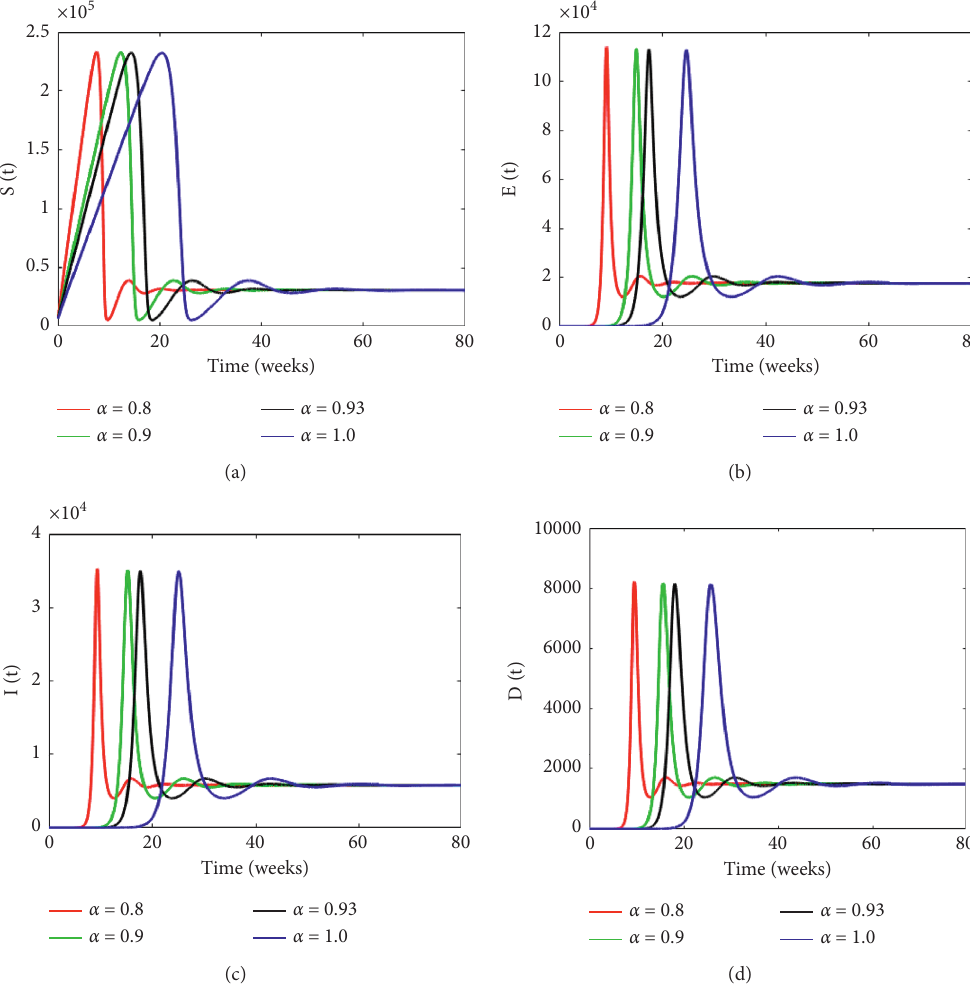
Figure 4: Dynamical solutions of model (8) for different fractional-order values. The initial population levels were assumed as follows: S ( 0 ) � 6900, E ( 0 ) � 0, I ( 0 ) � 1, and D ( 0 ) � 0. All model parameters are as in Table 2, and this yields R